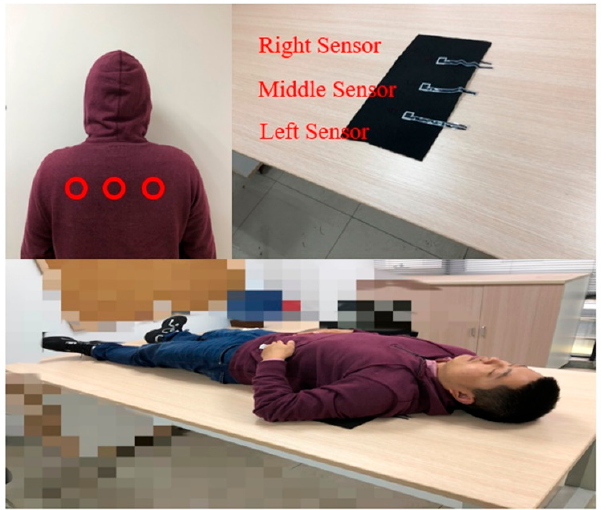
Sensors 2021 , 21 , x FOR PEER REVIEW Figure A8. Sensor capacitance change over time during 0% to 40% elongation at 0.5 s − 1 strain rate.